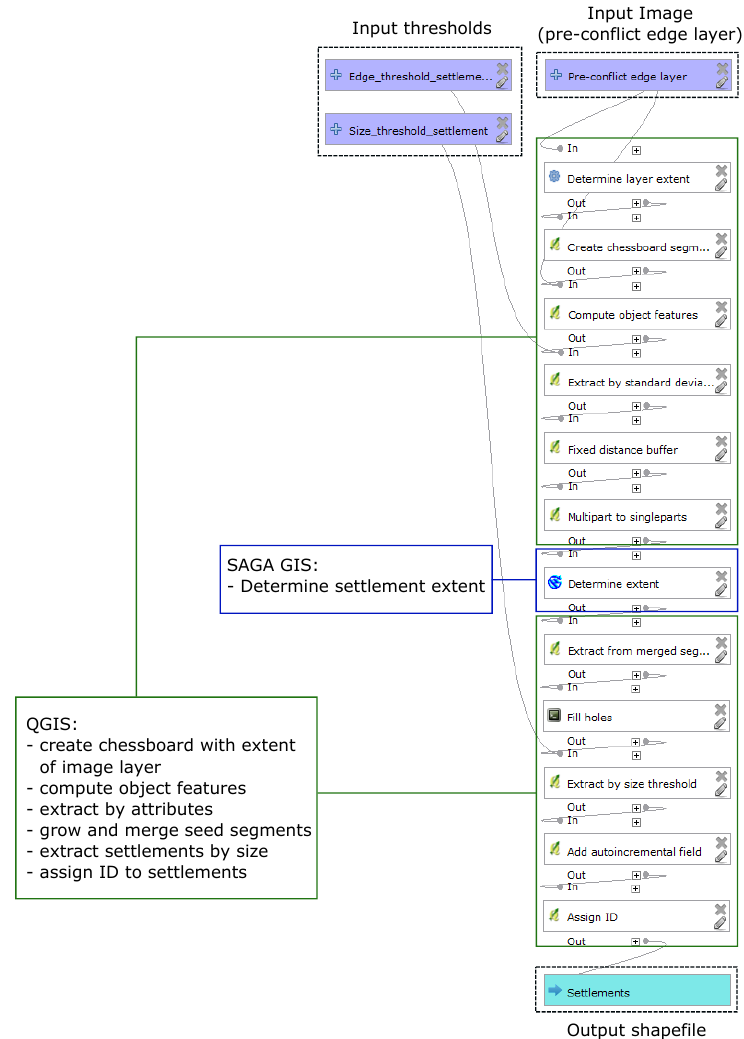
Figure A2. Screen-shot of analysis workflow in the QGIS graphical modeler with highlighting. Three inputs, two numerical thresholds and the pre-conflict edge layer are shown in purple at the top. The analysis steps are connected with grey arcs and executed from top to bottom. They are based on QGIS (green boxes) and SAGA GIS (dark blue box). This model is applied as one algorithm in the analysis workflow depicted in Figure 3. The model output is a single shape file with detected settlements, shown in turquoise at the